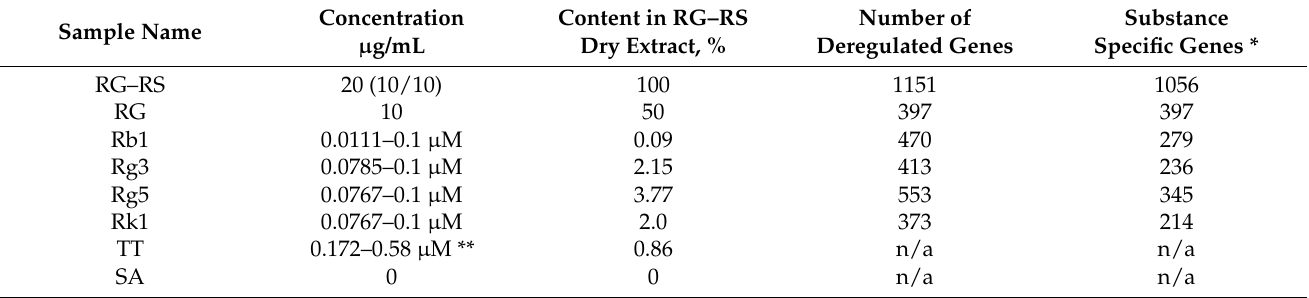
Table 1. Final concentrations of RG–SG, RG, and their active constituents, ginsenosides Rb1, Rg3, Rg5, and Rk1 in the hippocampal neuronal cell line HT22, and of the number of deregulated genes (>20 fold compared to control).